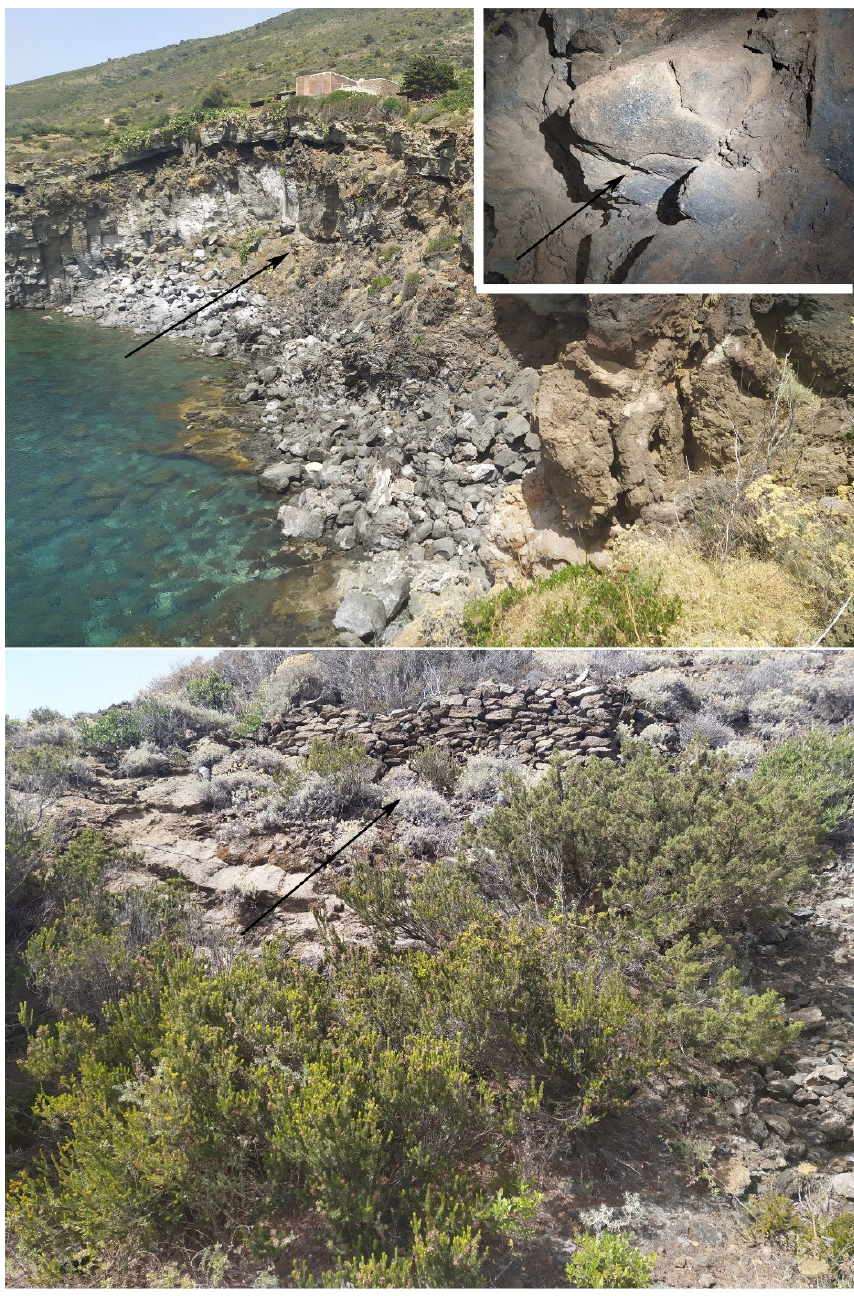
Figure 11. (Above ): Cala Rotonda, Martingana; the arrows indicate the area inhabited by Acheta pantescus n. sp.; in the inset, a volcanic rock photographed at night; the cricket sang inside the crevice (see arrow). ( Below ): Juniperus turbinata ; the cricket on the night of 6 July 2022 was singing behind this plant, and its recovery was the dry stone wall.